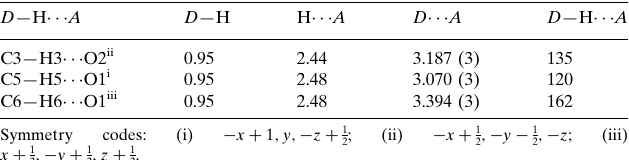
Hydrogen-bond geometry (A˚ , (cid:2)